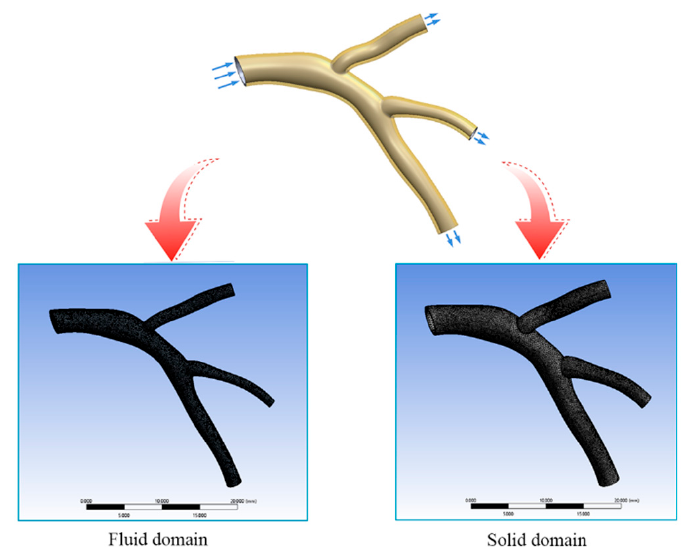
Figure 2. Mesh results of the fluid domain and solid domain.